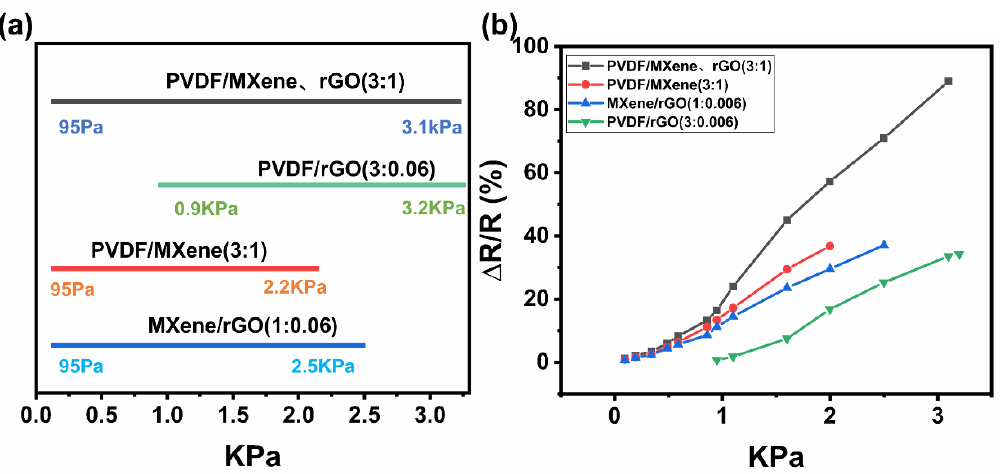
Figure 7. ( a ) Pressure detection range of different nanocomposite thin films and ( b ) the change in the relative resistance of different nanocomposite thin films.